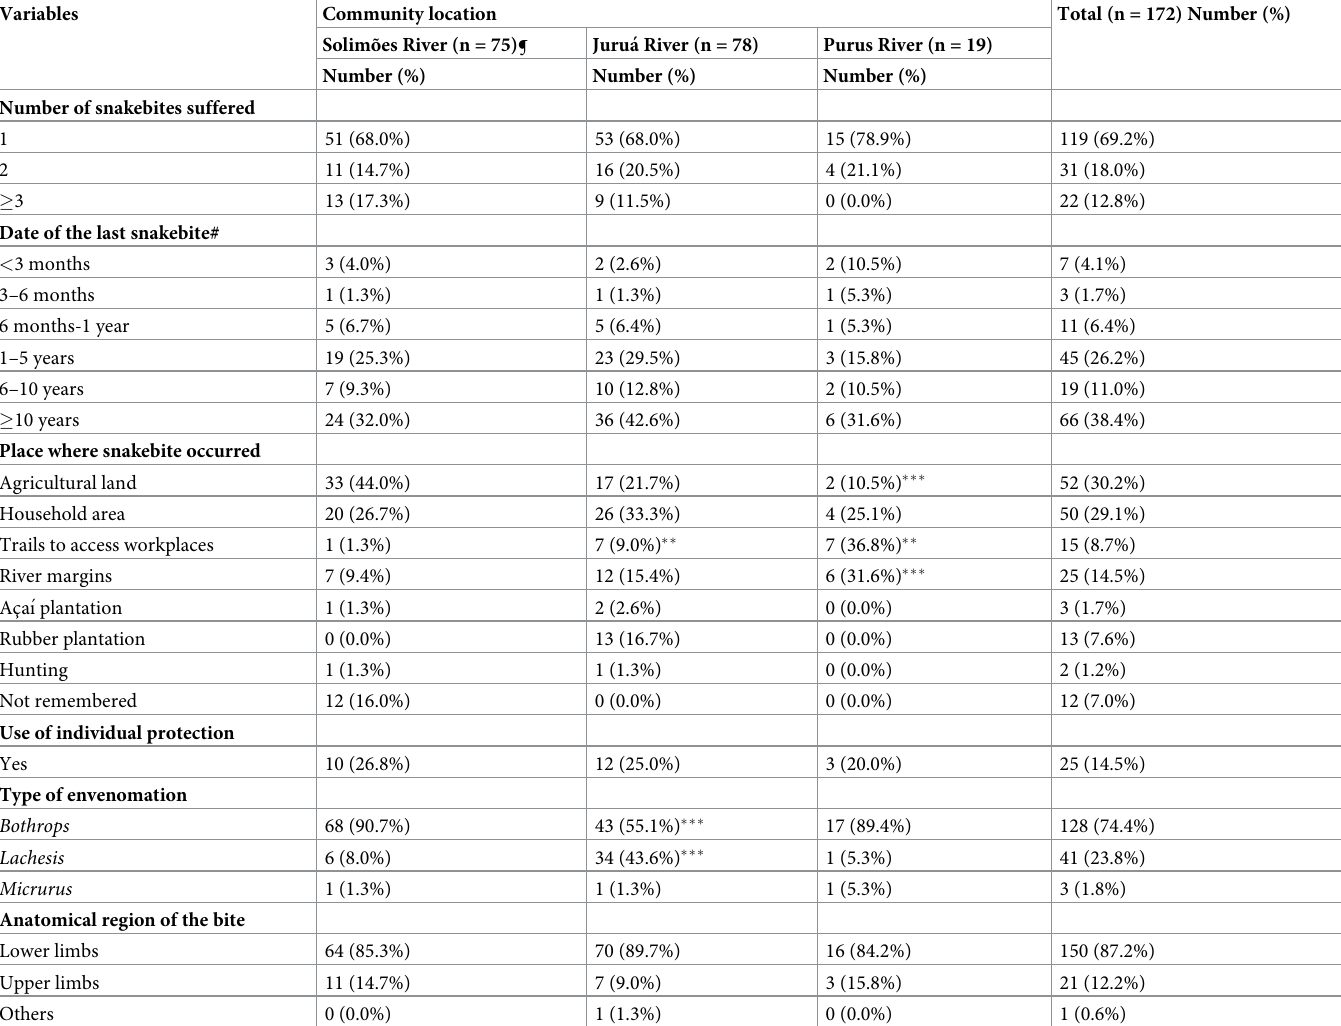
Table 2. Characteristics of the 172 study participants according to their history of